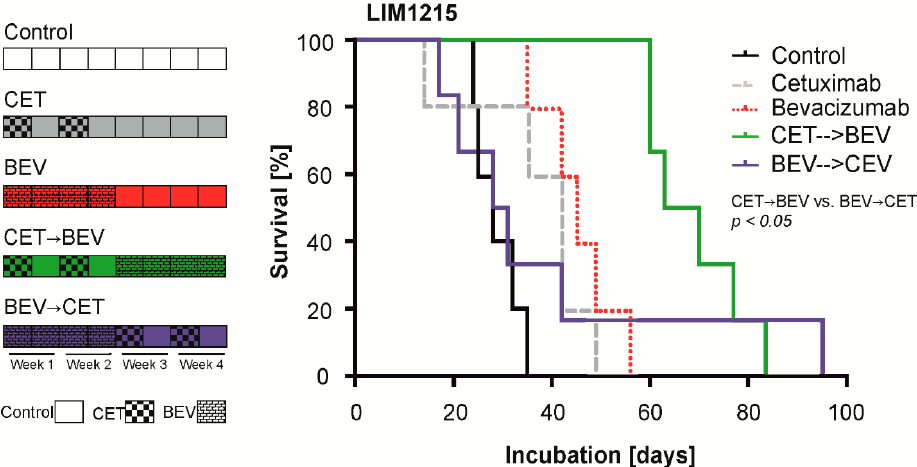
Figure 4. Cetuximab and bevacizumab in mono- or sequential therapy of subcutaneous LIM1215 tumors. Mice were treated either with PBS (control) for four weeks (two injections per week), with cetuximab (CET) for two weeks (one injection of CET 30 µg/g body weight and one injection of PBS per week), followed by PBS for two weeks (two injections per week), with bevacizumab (BEV) for two weeks (two injections of BEV 10 µg/g body weight per week), followed by PBS for two weeks (two injections per week), with CET for two weeks followed by BEV for two weeks (CET->BEV) or with BEV for two weeks followed by CET for two weeks (BEV->CET). Tumor volume was measured at the indicated intervals (control, CET, BEV: n = 5; CET->BEV, BEV-> CET: n = 6). To investigate whether this effect was also detectable in KRAS mutant colon carcinoma cells,